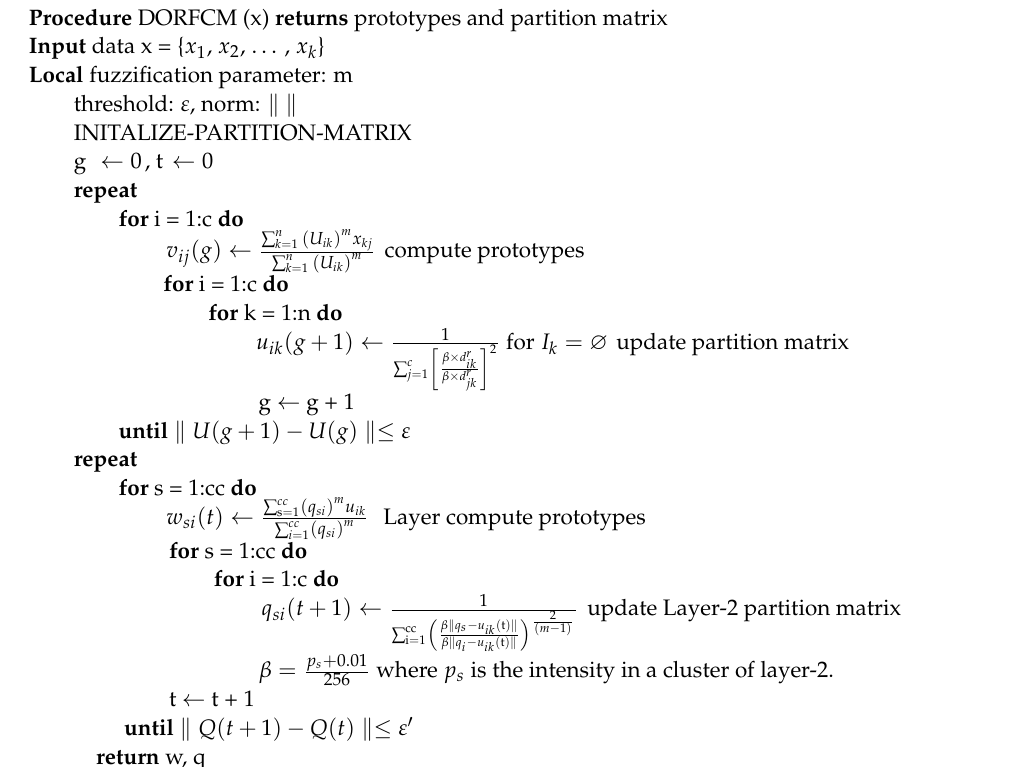
Algorithm 1. The proposed method algorithm